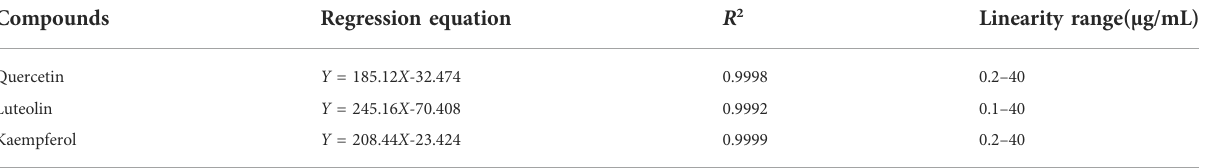
TABLE 6 The calibration curves and linearity range of the three main compounds. Compounds Regression